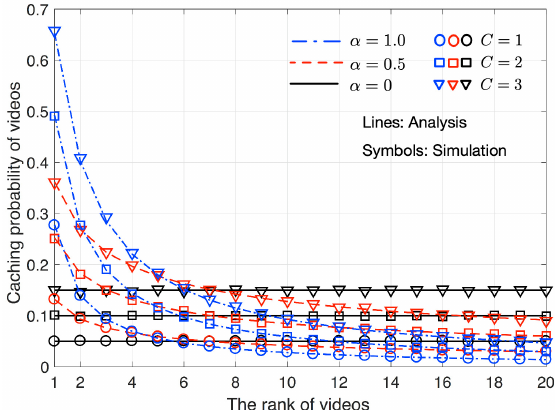
Figure 3. Probability that each content is stored in the cache according to its rank. C and α 0,1,1.5 ∈ { }